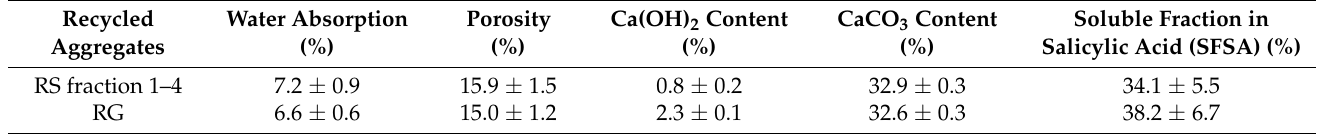
Figure 3. Phenolphthalein spraying on recycled aggregates RS ( left ) and RG ( right ). Table 1. Initial characterization of recycled